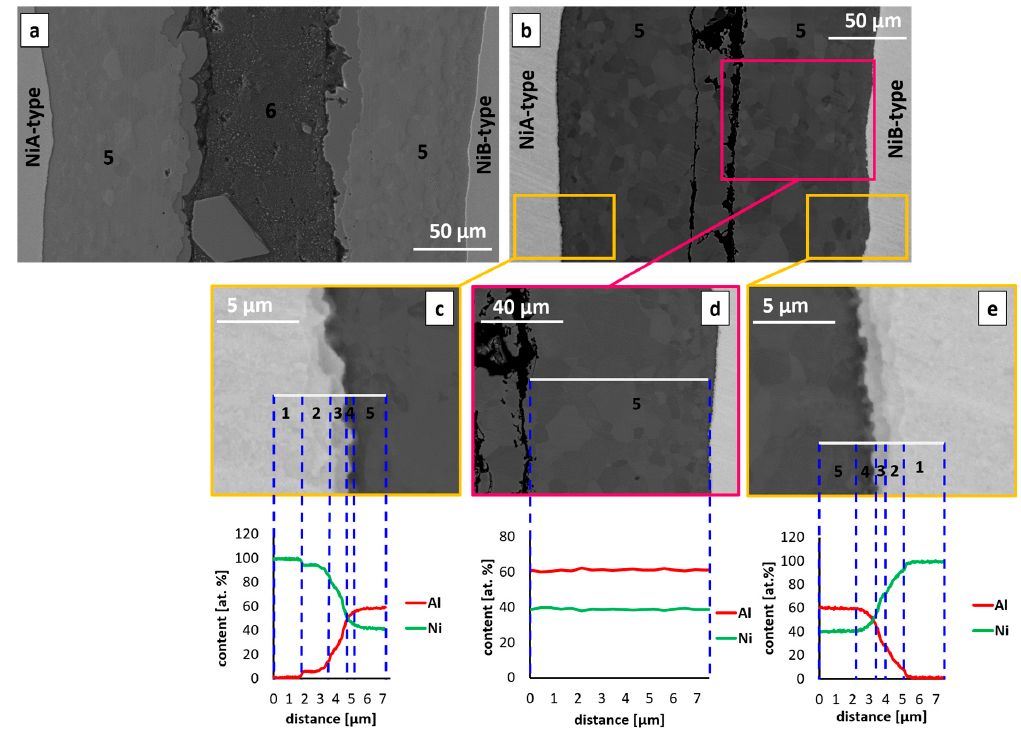
Figure 4. The SEM microstructures after ( a ) 15 min and ( b ) 30 min of reaction at 720 °C. The SEM microstructures in ( c – e ) present the magnified area of Al 3 Ni 2 /Ni interface. Numbers 1–6 denote various phases: 1-Ni, 2-Ni solid solution, 3-AlNi 3 , 4-AlNi, 5-Al 3 Ni 2 , 6-(Al)+Al 3 Ni.